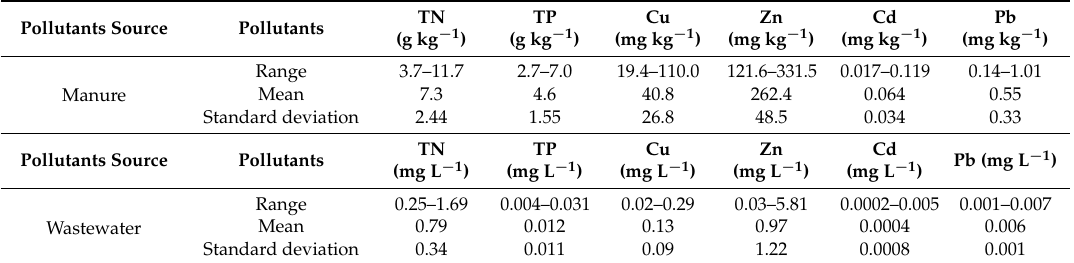
Table 3. Concentrations of primary pollutants in fresh manure and wastewater (mixed-up urine and washing wastewater) from sample pig farms ( n = 29).